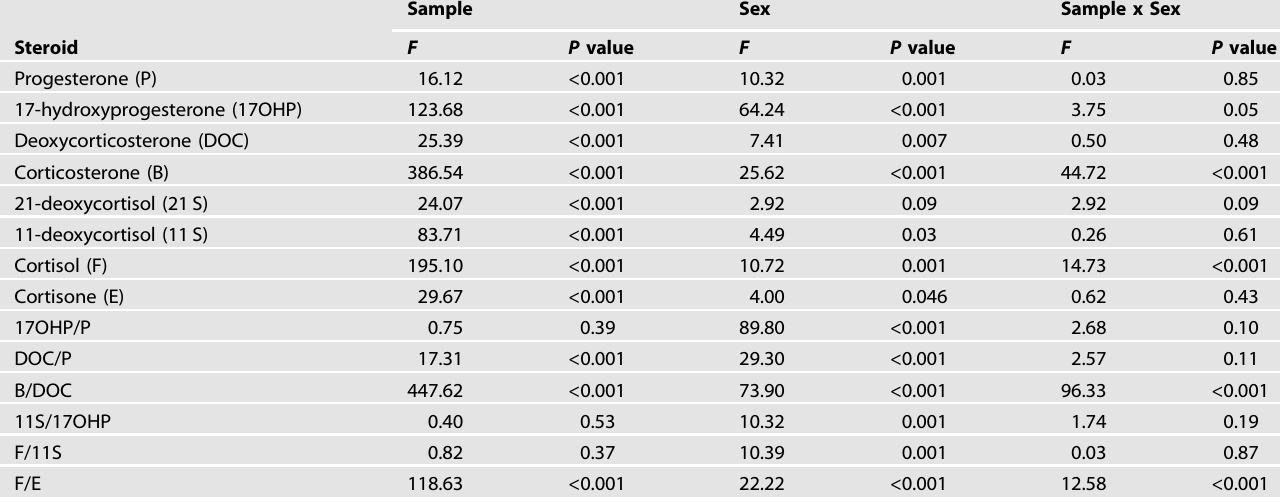
Table 4. Ranked ANOVA results.